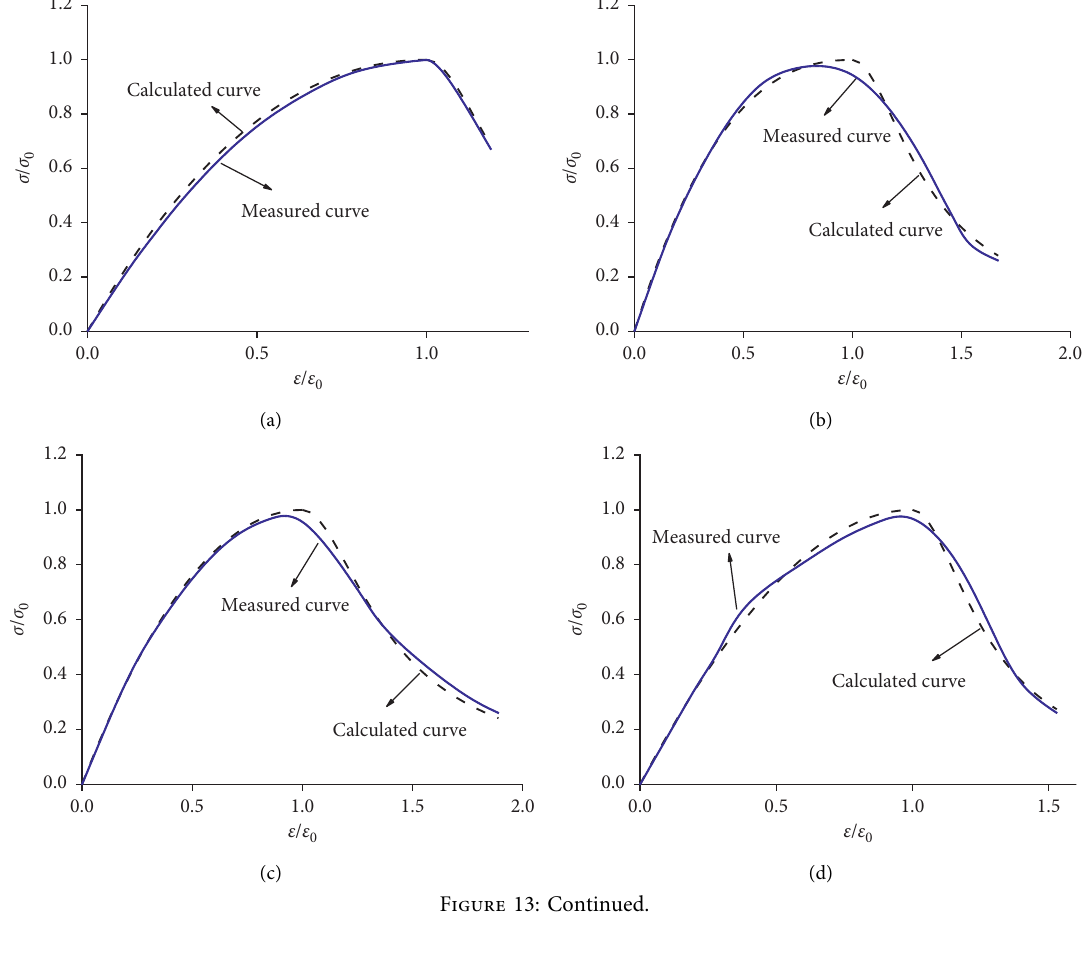
c . (a) Fitting curve of α a , α d , and